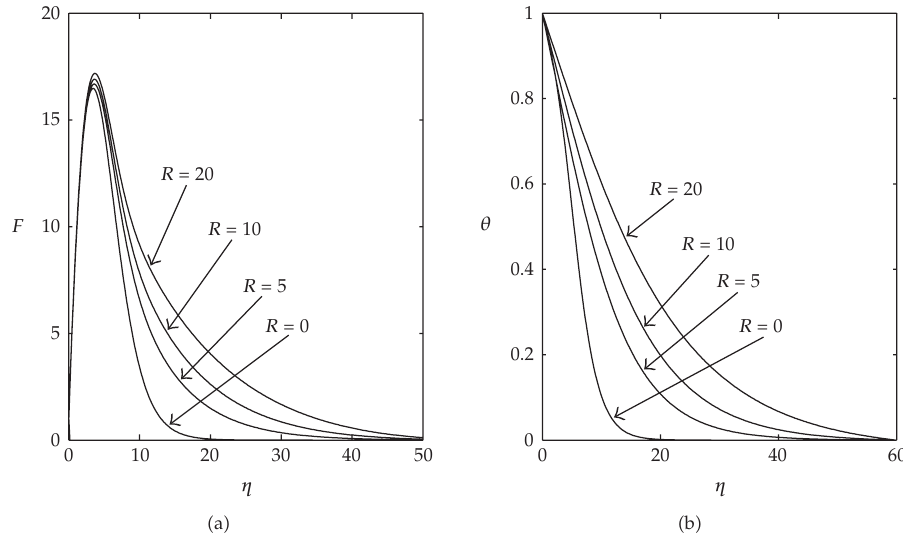
Figure 5: The variation of (cid:8) a (cid:9) velocity and (cid:8) b (cid:9) the temperature profiles with increasing radiation parameter numbers with ξ (cid:7) 5 , Gr (cid:7) Gr c (cid:7) 1 , Pr (cid:7) 0 . 72 , V 0 (cid:7) 0 . 1 , Sc (cid:7) 1